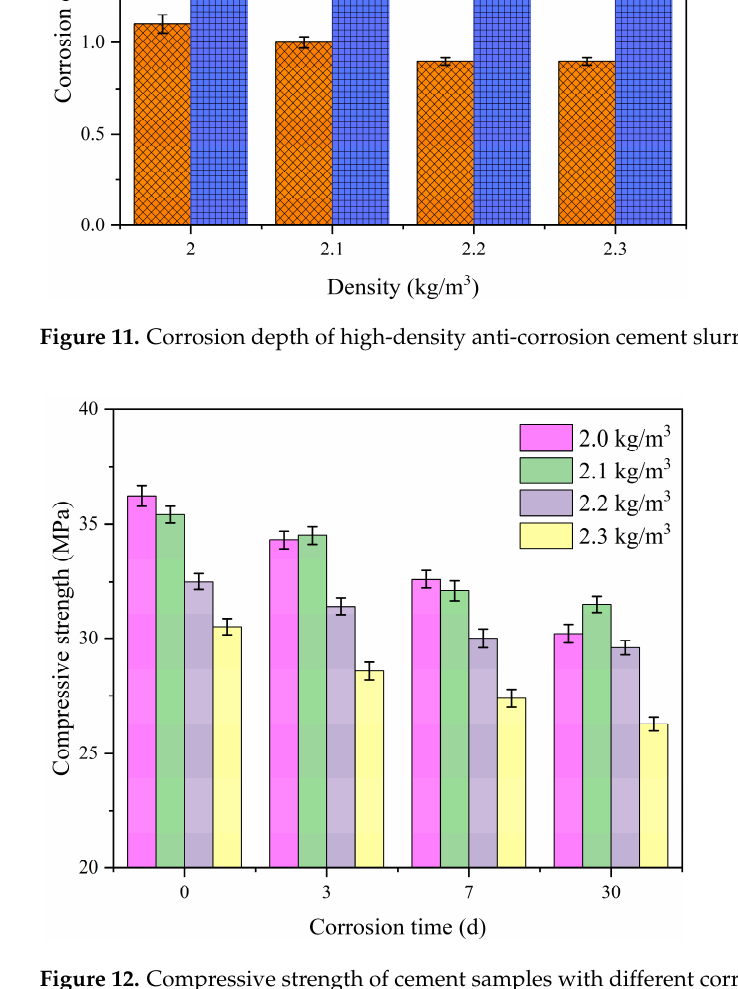
( b ) Figure 13. Morphology of 2.0 kg/m 3 cement sample: ( a ) non-corroded; ( b ) corroded.